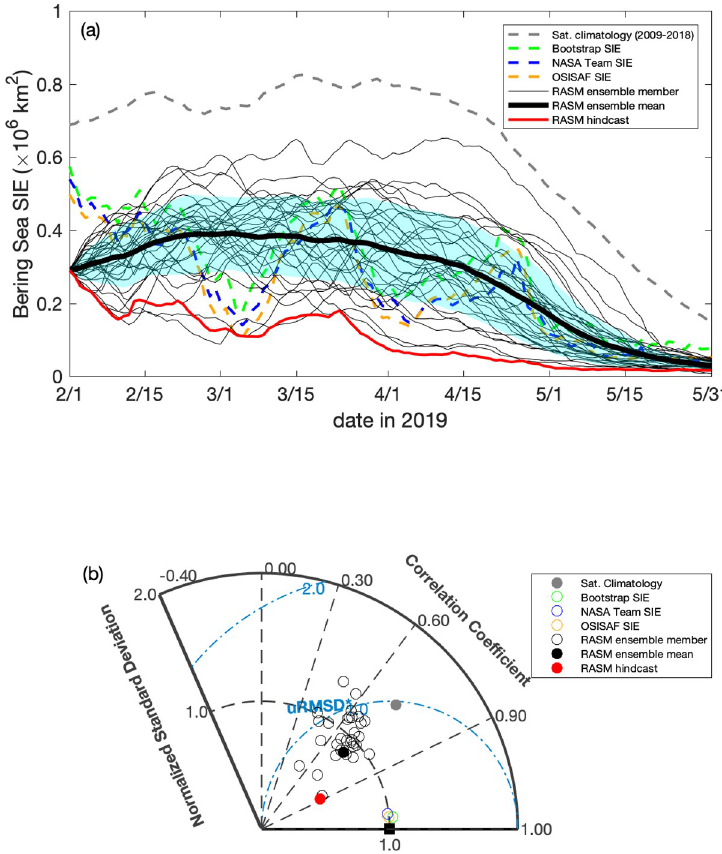
Fig 15. Daily sea ice extent during February–May, 2019 from RASM compared with satellite observations. (a) Daily timeseries of sea ice extent in the Bering Sea during February to May, 2019 from the RASM forecast, RASM hindcast, and satellite algorithms, with light blue shading representing 1 standard deviation from the forecast ensemble mean. The gray dashed line is the satellite-derived (Bootstrap, NASA NT, and OSISAF) daily climatology between 2009 and 2018. (b) Taylor diagram showing the normalized correlation coefficient (r), standard deviations ( σ ), and the unbiased root-mean-square difference (uRMSE) for the timeseries. The Taylor diagram illustrates a relative model performance in reproducing satellite-derived Bering Sea daily SIE variability, as well as the individual data sets, relative to the average of Bootstrap, NASA NT, and OSISAF products, represented by the black square as the reference where the normalized standard deviation and the correlation coefficient are 1.00 and the unbiased root mean difference is 0.00. Figure created using Matlab (v. 2018a).